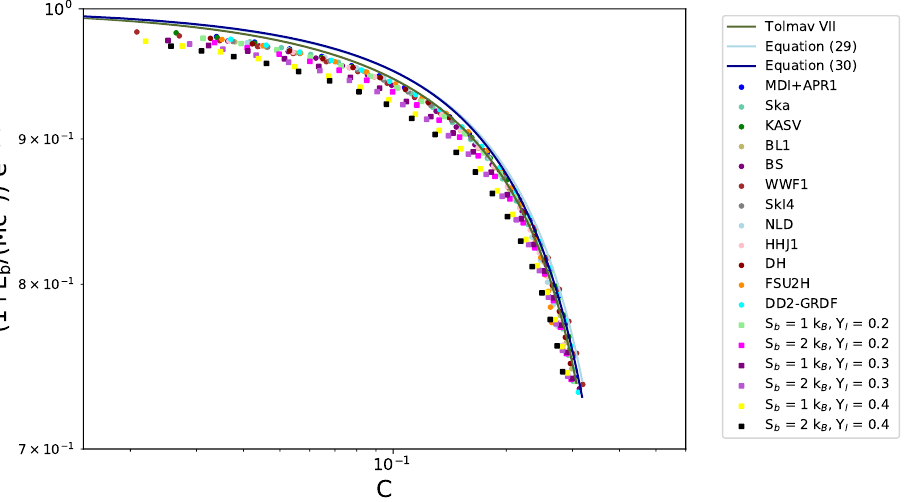
Figure 7. Universal relation between the neutron star compactness and the rescaled binding en- ergy. The circular and the rectangular points stand for cold and isentropic EOSs, respectively. The corresponding fit of Lattimer and Prakash [45] of Equation (29) and the fit of Breu and Rezzolla of Equation (30) are also plotted for